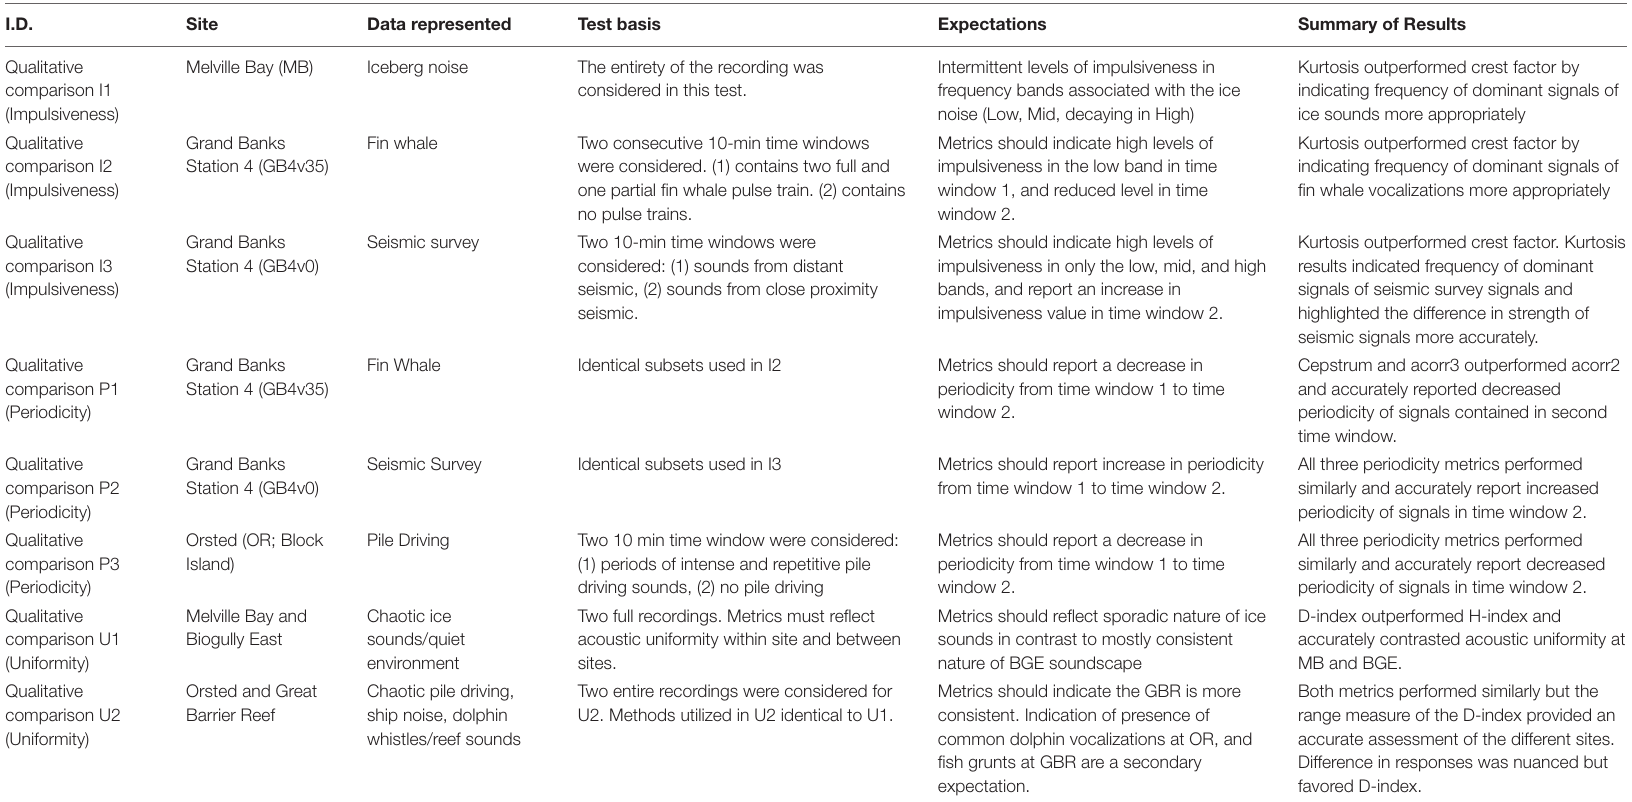
TABLE 4 | Qualitative comparisons of soundscape code property metrics and summary of